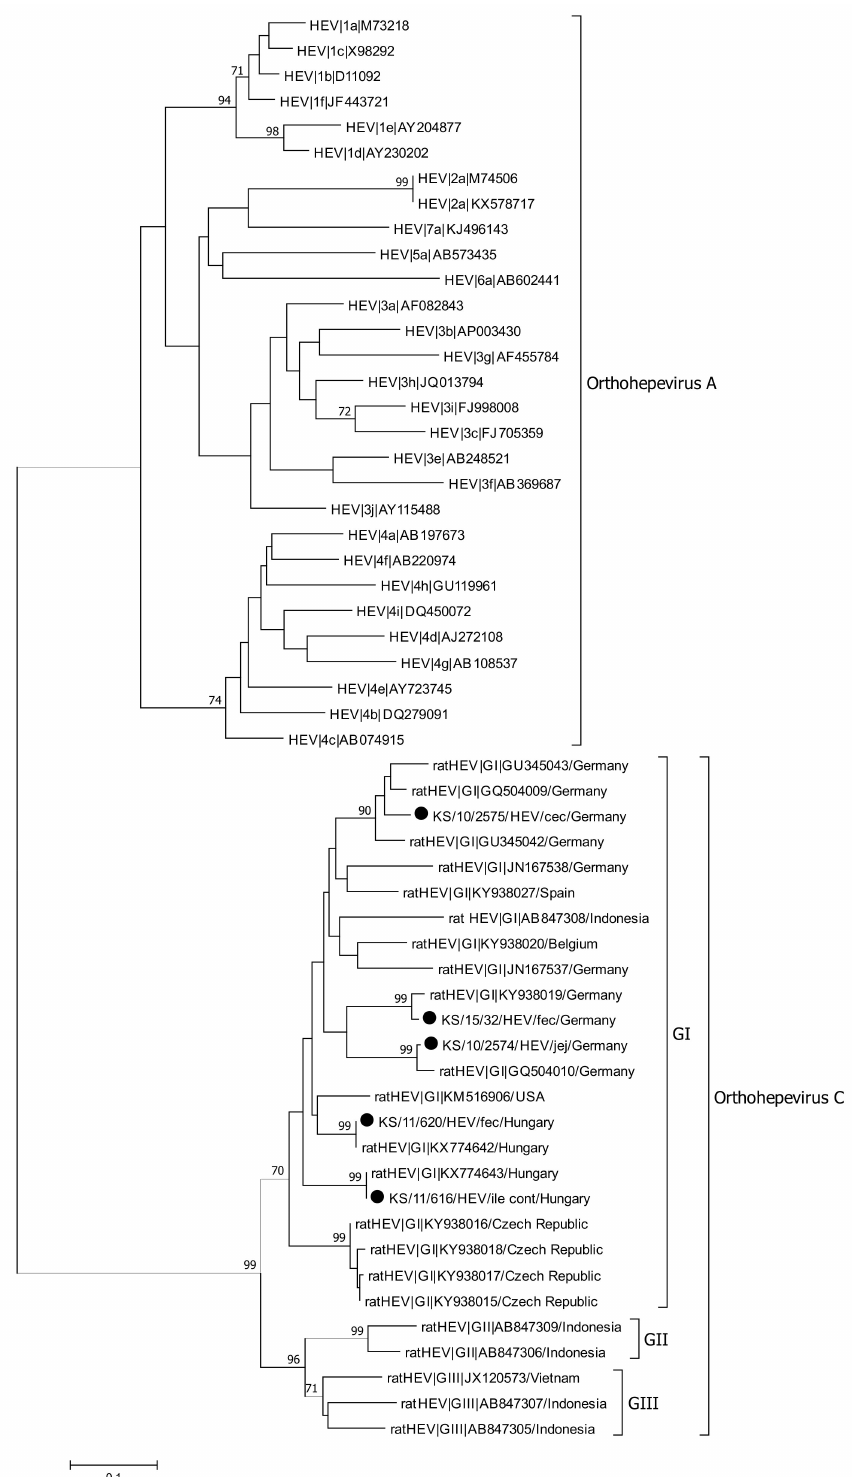
Figure 4. Phylogenetic analysis of a 312 nt fragment of ORF1 from HEV strains detected in this study (marked with dot) and reference sequences of species Orthohepevirus C and Orthohepevirus A . The phylogenetic tree was reconstructed using the Neighbor-Joining method with Bootstrap test (1000 replicates) and the Tamura–Nei parameter method available in MEGA7. The bar indicates the number of substitutions per site. Bootstraps values above 70 are shown. Abbreviations: cec = cecum; cont = content; fec = feces; ile = ileum; jej =